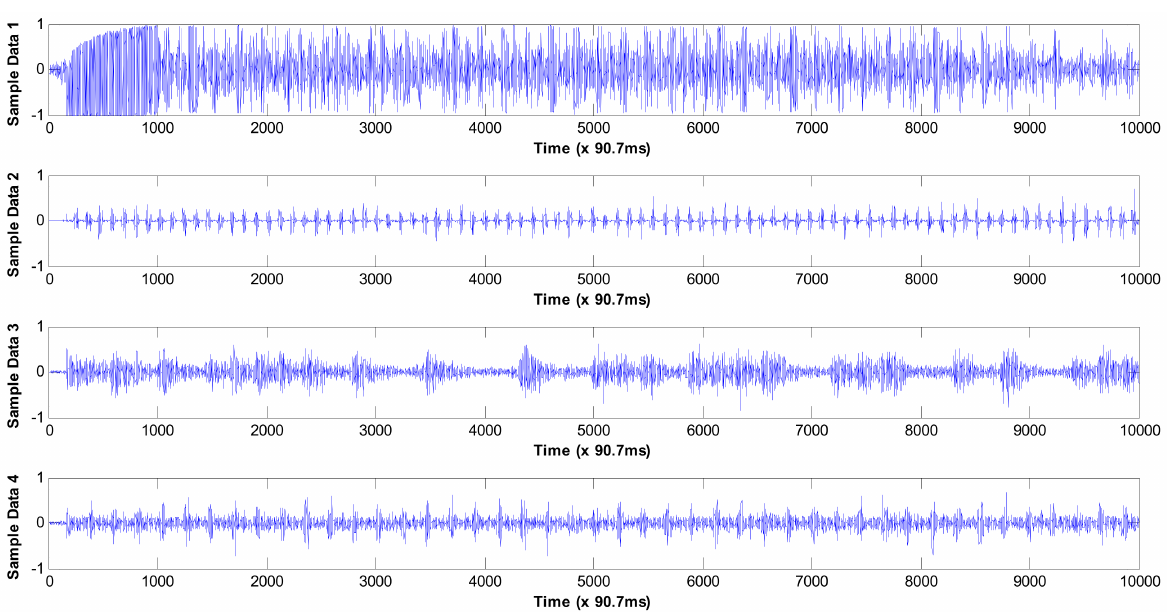
Figure 4. Time domain data extracted.